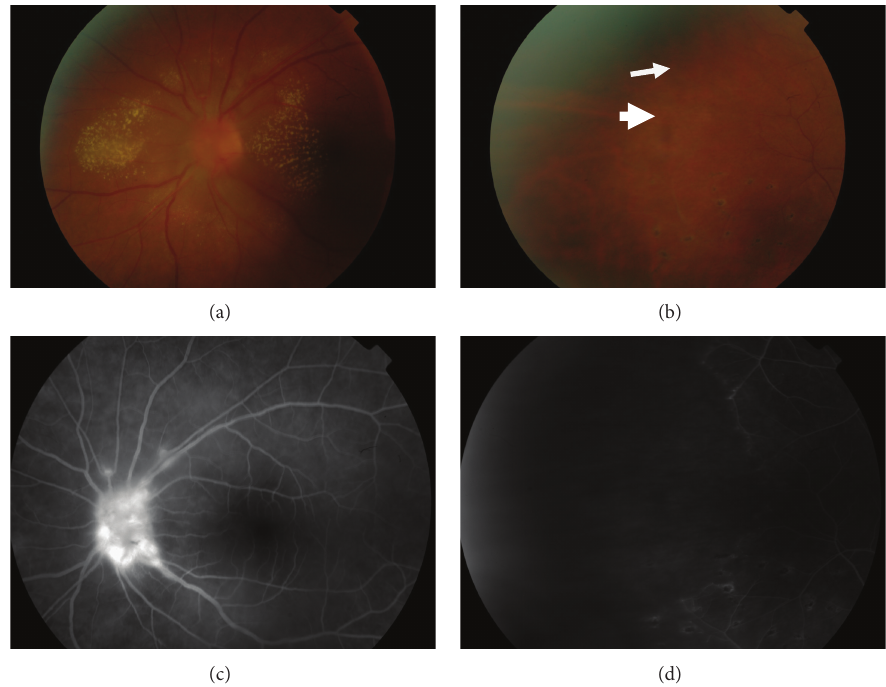
Figure 8: Fundus images of a patient with IRVAN syndrome. (a) Color image showing retinal exudates at the posterior pole involving the macula together with optic disc swelling and hyperemia. (b) Multiple pigmented chorioretinal lesions at the midperiphery (arrow head) together with evidence of vascular sheathing (arrow). (c) Fundus fluorescein angiography showing dye leakage at the optic disc. (d) Wide area of retinal